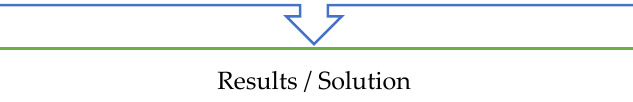
Figure 13. Diagram of the solution of the thermal model.